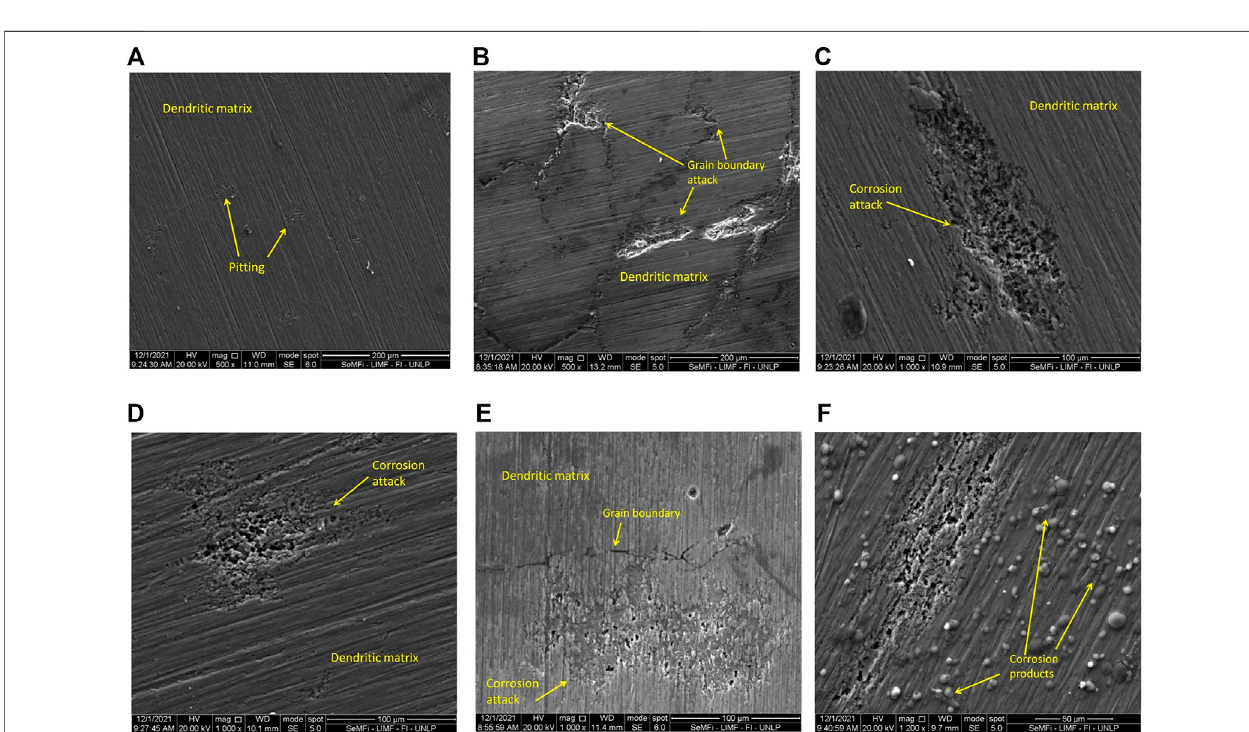
FIGURE 7 | SEM micrographs of Al-Mg alloys after corrosion tests: (A) Al-0.5wt.%Mg columnar zone (longitudinal). (B) Al-0.5wt.%Mg equiaxed zone (longitudinal section). (C) Al-0.5wt.%Mg columnar zone (transversal section). (D) Al-0.5wt.%Mg equiaxed zone (transversal section). (E) Al-2wt.%Mg columnar zone (longitudinal section). (F) Al-2wt.%Mg equiaxed zone (longitudinal